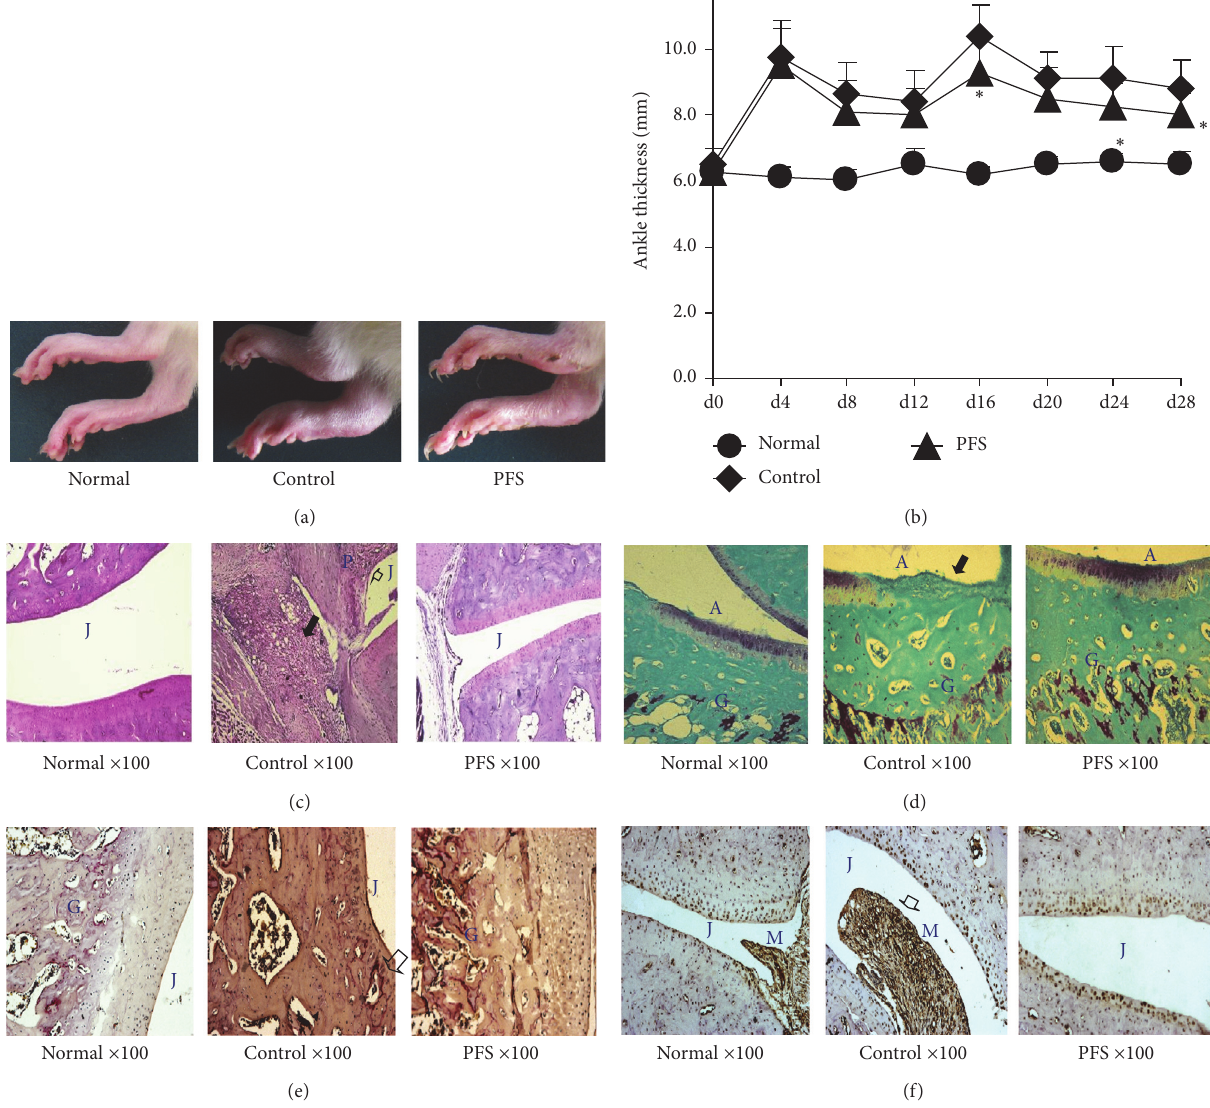
Figure 1: PFS prophylactically suppress inflammation in CFA-induced arthritis in rats. AIA was induced as detailed in Methods. Rats were randomly divided into 3 treatment groups: normal, control, and PFS. PFS were administered orally until the day before tissue harvesting 28th day. (a) Representative photographs of days 21–27 paws from the 3 treatment groups. (b) Change in ankle thickness. The changes in paw thickness were measured every four days. The results are expressed as the mean ± standard error ( 𝑛 = 7–9). Statistical values conducted on days 0–28 for changes in paw thickness compared with control were as follows: ∗ 𝑝 < 0.05 compared with the control group, Dunnett’s test. ((c)–(f)) Representative photographs of knee joint tissues stained with safranin-O-fast green, toluidine blue-fast green, TRAP, or MMP-11 (magnification, 100x). Note that the intense synovial inflammatory infiltration ((c) black arrowhead), pannus formation ((c) arrowheads), cartilage destruction, extensive proteoglycan depletion ((d) black arrowhead), and MMP-11 infiltration ((f) arrowhead) were significantly reduced in the joints of PFS-treated rats compared with the respective control rats. A: articular cartilage; G: growth plate; J: joint space; M: synovial membrane; P: pannus